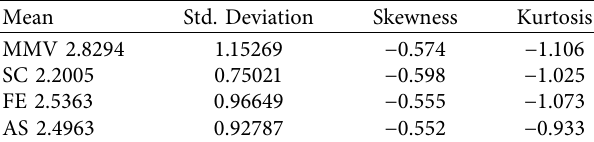
Table 3: Descriptive analysis of